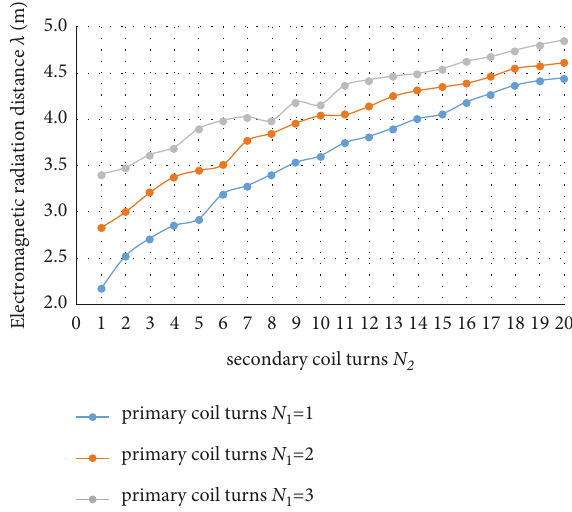
Figure 8: Relationship between magnetic field intensity exceeding limit and coil